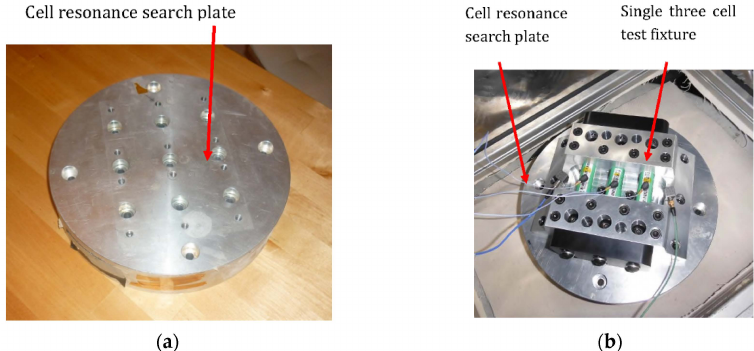
Figure 4. ( a ) Cell resonance search plate ( b ) Cell resonance search plate with single 18,650 three cell fixture installed on VP85 electromagnetic shaker (EMS).